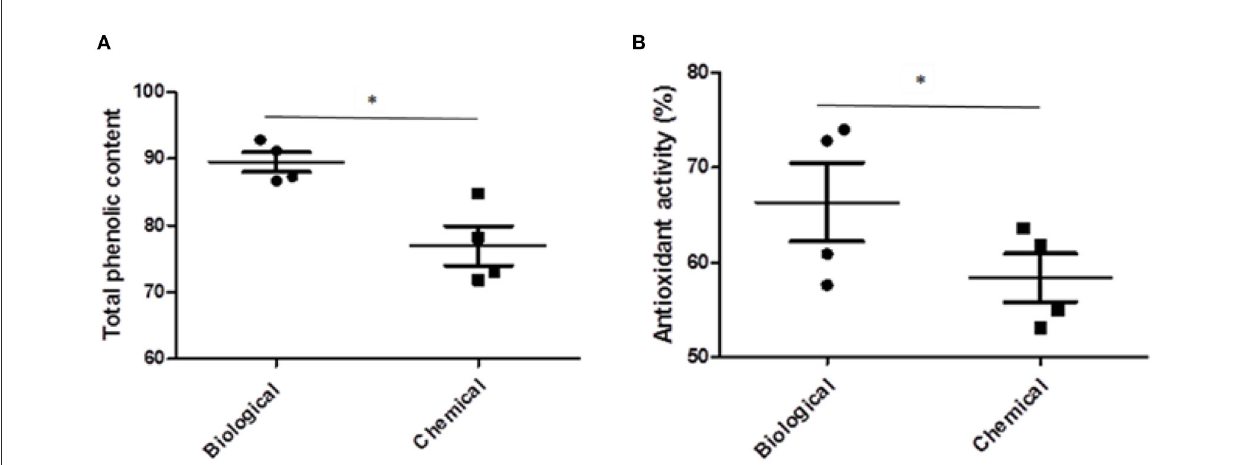
FIGURE2 The effect of biological and chemical treatments on the total phenolic content (A) and antioxidant activity (B) of sweet pepper fruits. Asterisk indicates a statistically significant effect (* p < 0.05) between biological and chemical treatments.